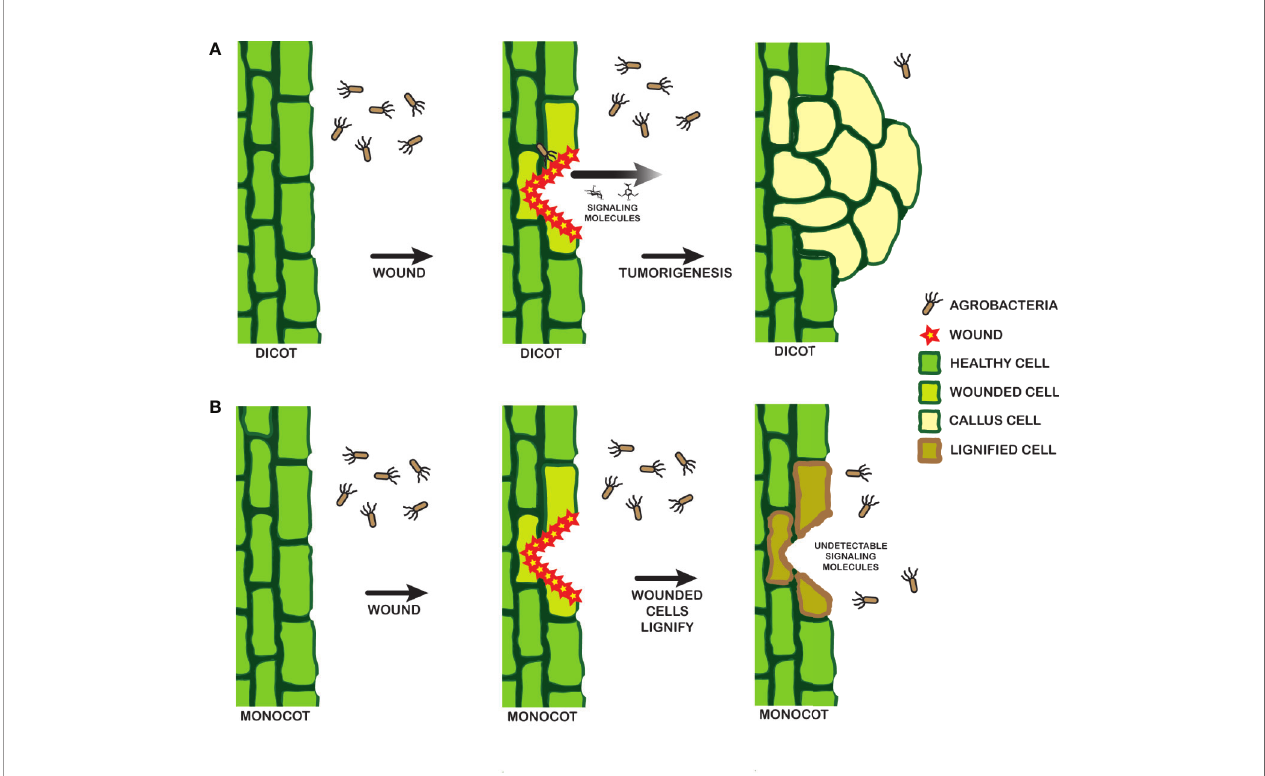
FIGURE 9 | Model for signal landscape of monocots and dicots. In dicots (A) , wounding events release detectable signals into the rhizosphere, which can be recognized by a pathogenic Agrobacterium . Chemotaxis follows, leading to DNA transfer and tumorigenesis. Wounding in monocots (B) , in contrast, leads to ligni fi cation in the cell walls and a lack of strong signals by a pathogenic Agrobacterium